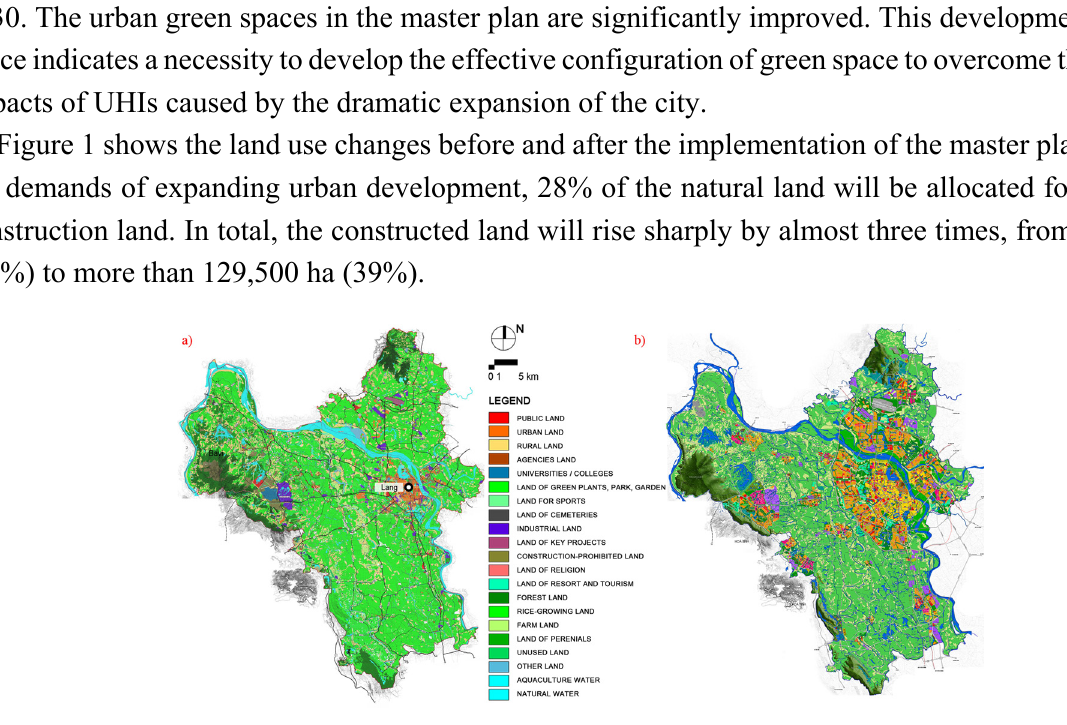
Figure 1. Land use and land cover for ( a ) the current status and ( b ) the Hanoi Master Plan 2030. Source: Vietnam Institute of Architecture, Urban and Rural Planning (VIAP),